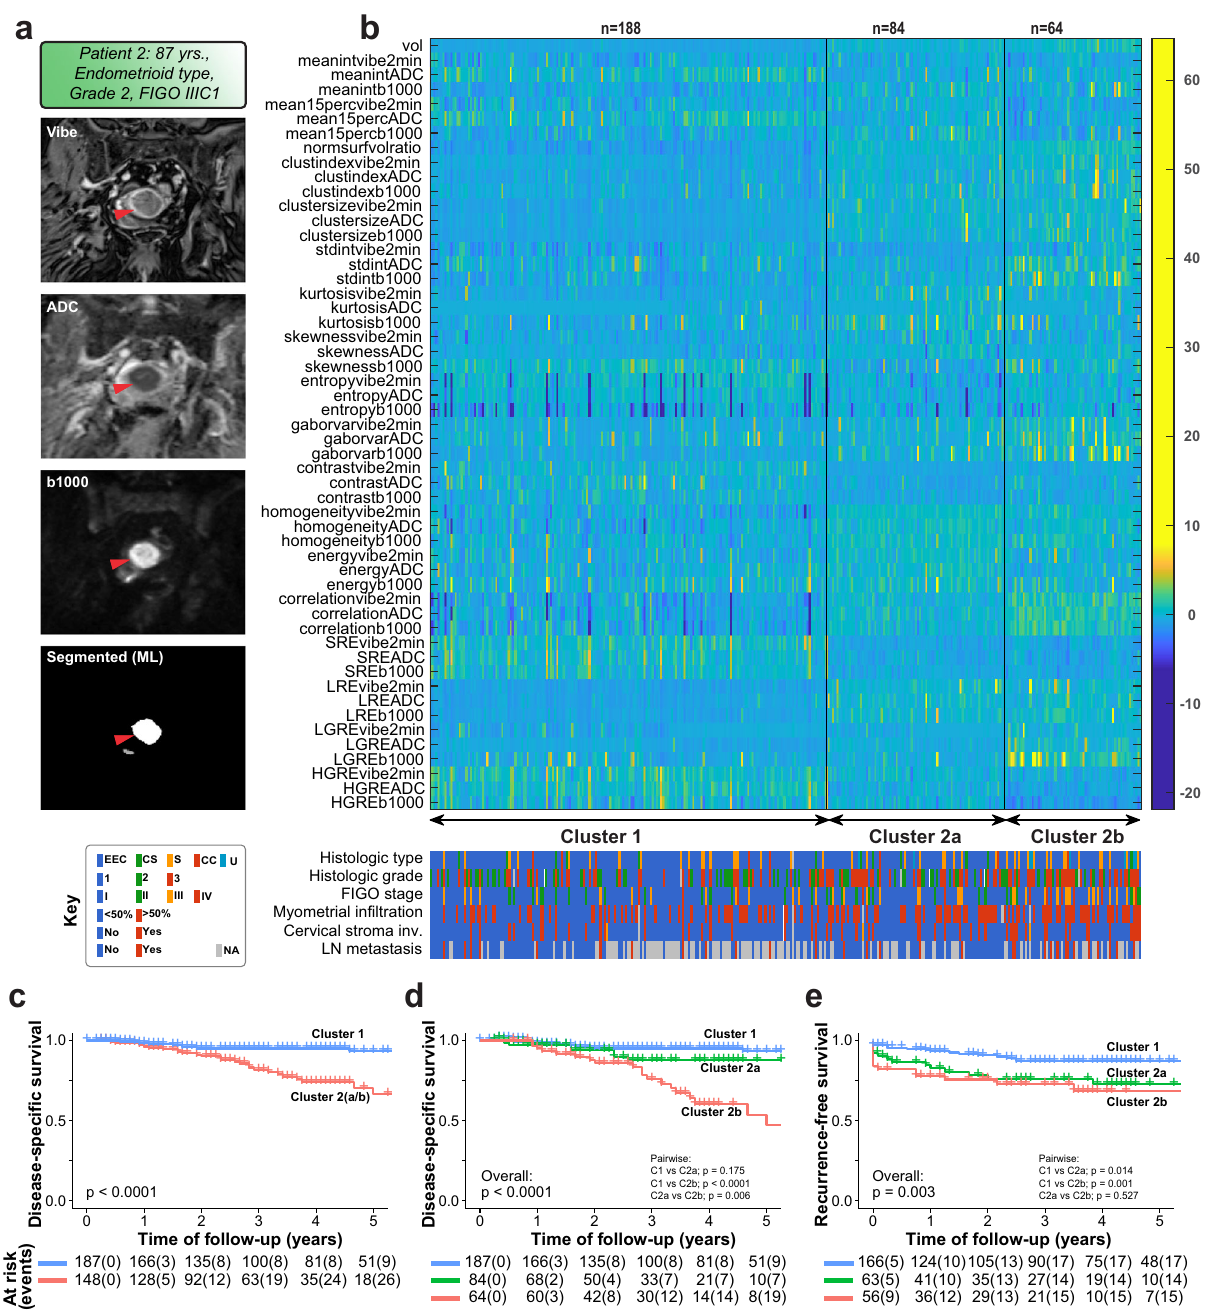
Fig. 4 Radiomic clustering of ML segmented tumors in 336 EC patients reproduces three distinct clusters with different prevalence of high-risk features. a Preoperative pelvic MRI with automated ML-based tumor segmentation of EC tumor (red arrows) of a patient with endometrioid type, histologic grade 2, and FIGO stage IIIC1. Tumor segmentation was performed by a machine learning (ML) algorithm trained on the segmentation data from the manual segmentation cohort. The radiologic images of the ML-cohort of VIBE + C, ADC, b1000, and tumor segmentation were used for radiomic pro fi ling similar to the manual segmentation-cohort. b Heatmap depicting the three distinct radiomic clusters and corresponding clinico-pathologic features capturing different levels of tumor aggressiveness. Patients in cluster 2a ( n = 84) and 2b ( n = 64) more often had clinico-pathological variables known to be associated with high-risk disease, compared with that of patients in cluster 1 ( n = 188). c – e Survival analysis in relation to the radiomic clusters highlighting a signi fi cantly poorer survival for patients in cluster 2. Disease-speci fi c survival comparing clusters 1 and 2a/b combined ( c ), all three clusters ( d ), or by recurrence ( e ). Number of events in brackets. Histological types; EEC endometrioid, CS carcinosarcoma, S serous, CC clear cell, U